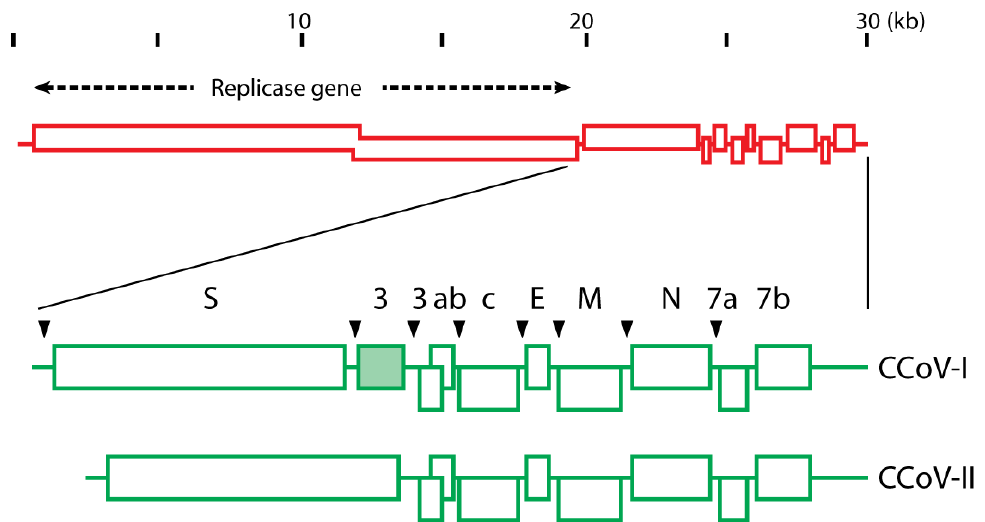
Figure 1. Image representation of the genomes of CCoV-1 and CCoV-II. Adapted from Lorusso et al.